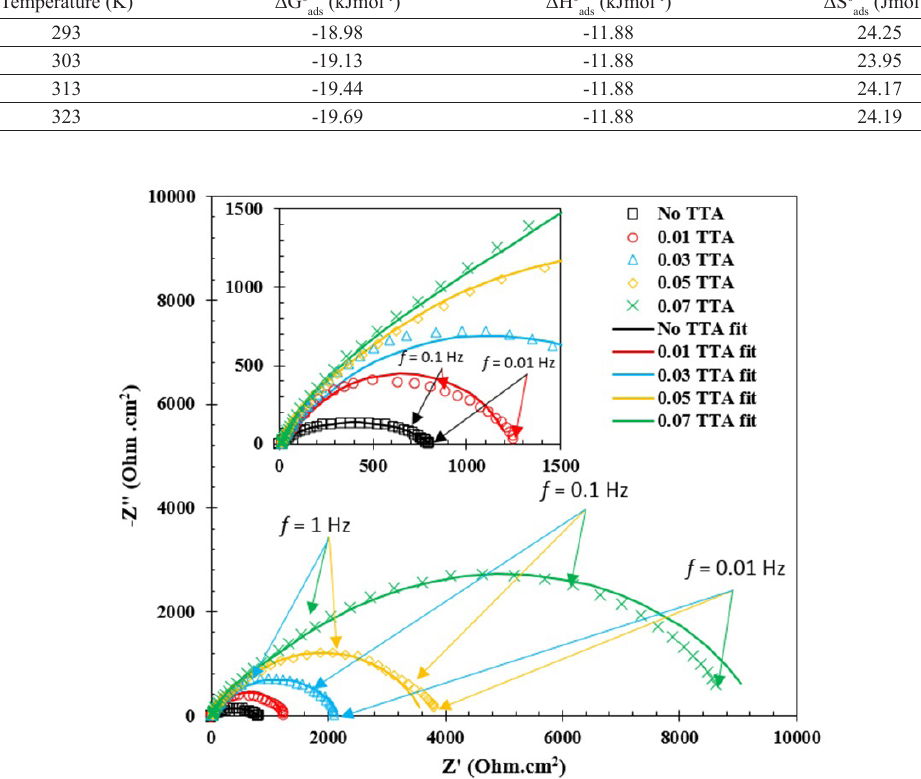
Table 4. Thermodynamic parameters of the adsorption isotherm of TTA on Mild steel surface in HCl solution. Temperature